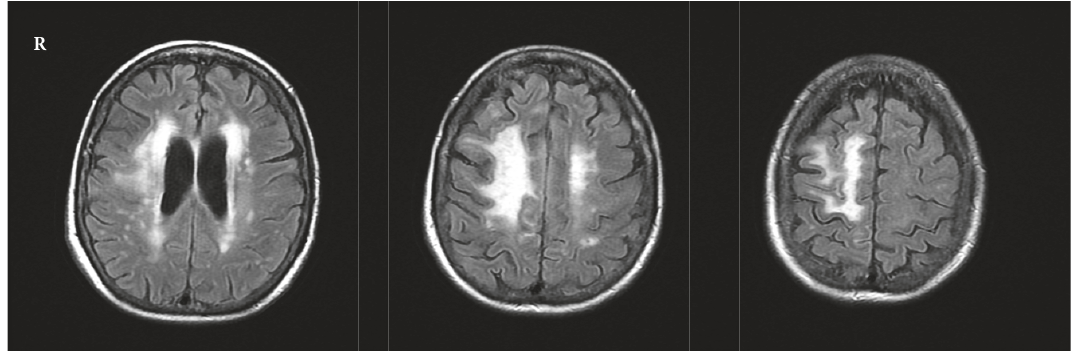
Figure 1: MRI with contrast shows multifocal T2 hyperintense abnormalities with the largest focus in the right frontal lobe.